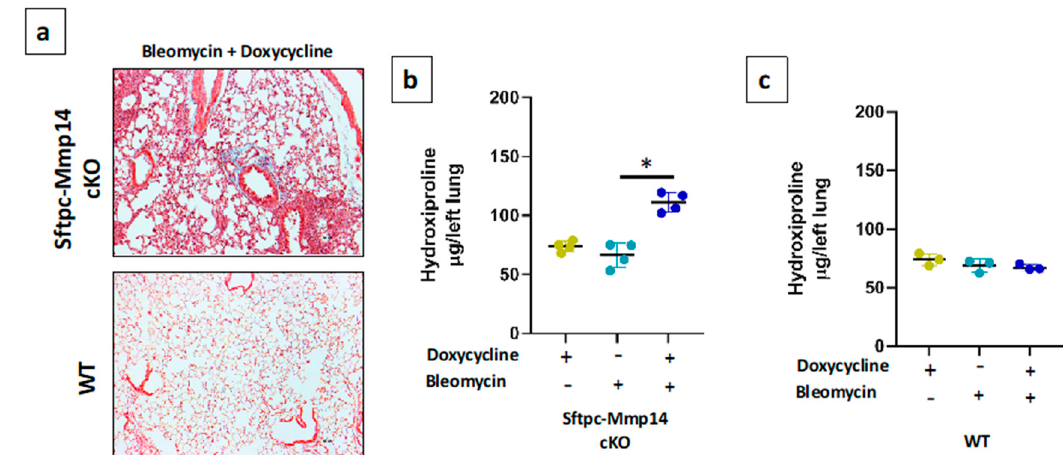
Figure 4. Lung injury induced with bleomycin in Sftpc-Mmp14 cKO and WT mice sacrificed at 120 days (resolution phase). ( a ) Representative micrograph stained with Masson’s trichrome (blue) for collagen deposition throughout the lungs of Sftpc-Mmp14 cKO and WT mice in presence of doxycycline. Hydroxyproline content in ( b) Sftpc-Mmp14 cKO and in ( c) WT mice, after bleomycin treatment in the absence or presence of doxycycline. * p < 0.05 by one-way ANOVA with Tukey post-test n ≥ 3. Scale bar 100 μ m.